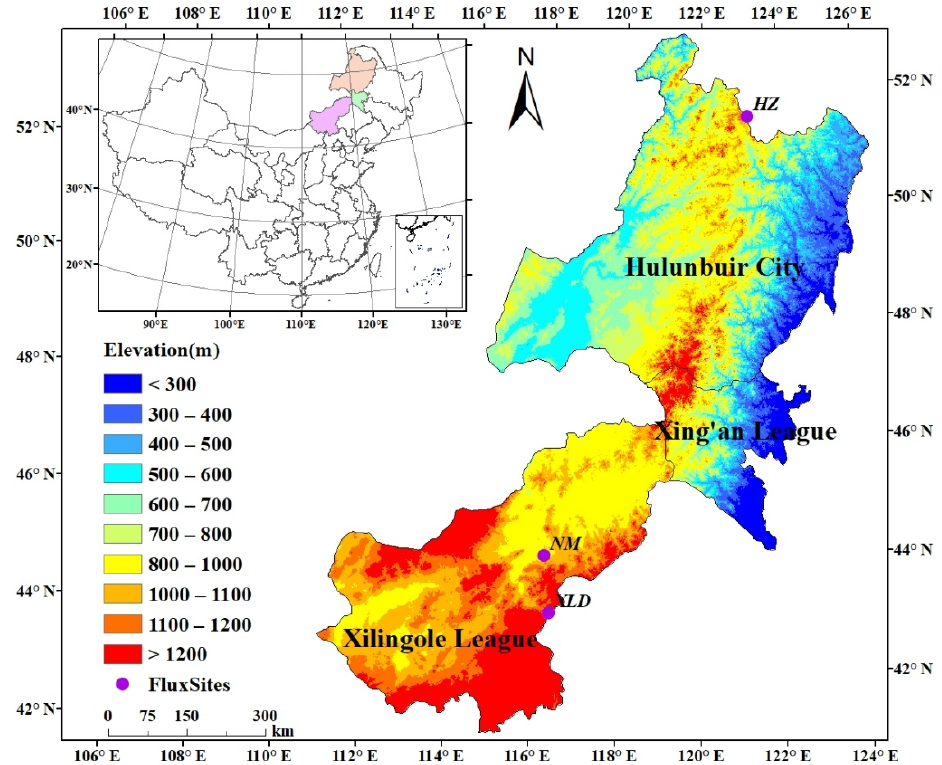
Figure 1. The geographical location and topography of eastern Inner Mongolia.